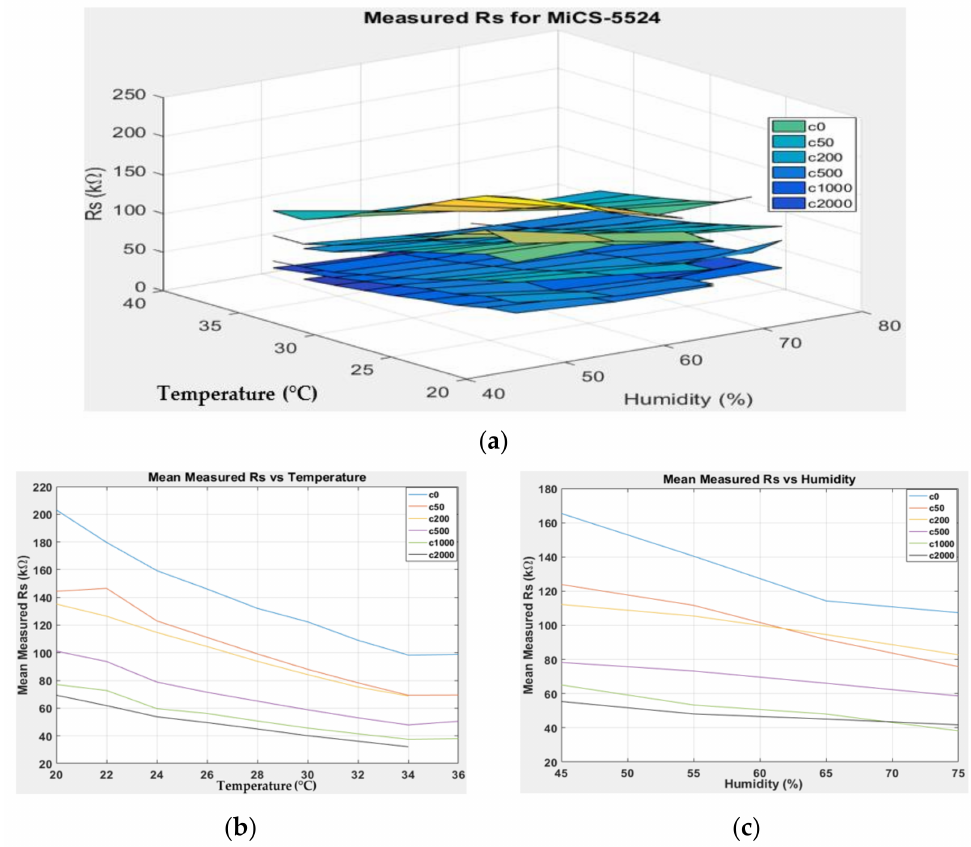
Figure 7. ( a ) Three-dimensional surface graph of MiCS-5524 measured R S at varying temperature and humidity levels and different ethanol solution concentrations, ( b ) mean of measured R S versus temperature, and ( c ) mean of measured R S versus